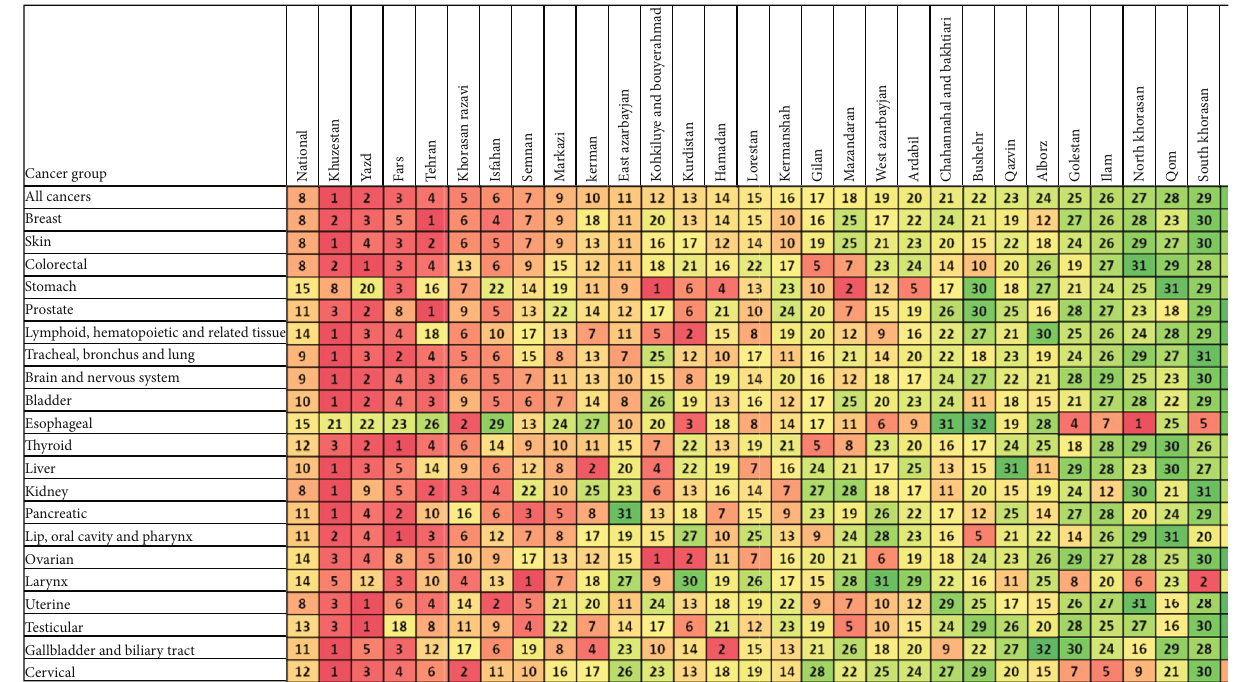
Figure 4: Iran ’ s provinces ranked by age-standardized rate (ASR) in both sexes for each cancer group 1 , 2016. 1 National ASR is also included in the fi rst column for better comparison. Colors correspond to the ranking (dark red is the cancer group with the most incidence, and dark green is the cancer group with the least incidence for cancer indicated). The numbers inside each box indicate the ranking. The provinces were sorted based on their 2016 ASR in Iran. “ Other cancers ” group is not included in the